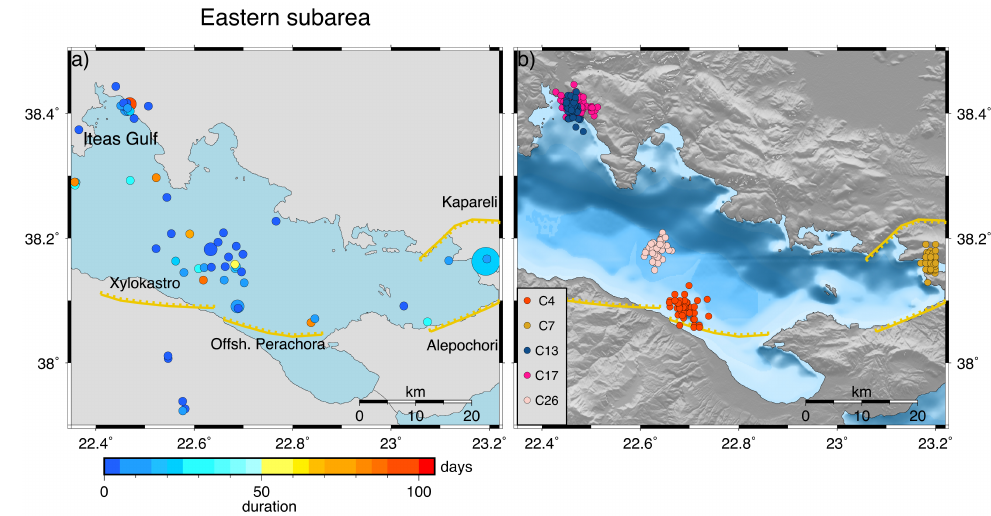
Figure 5. ( a ) Spatial distribution of the centroids of the identified clusters for the eastern subarea of the Corinth Gulf along with the major faults (yellow lines). The size of the circles is proportional to the earthquake number in each cluster whereas the duration is represented by the color scale. ( b ) Spatial distribution of the clusters with N ≥ 30 events. The index of each cluster is provided in the inset